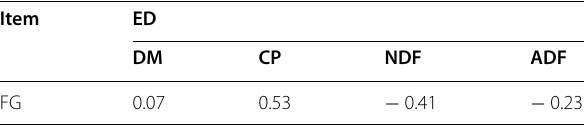
Table 4 Pearson correlation coefficient of FG content and ED of